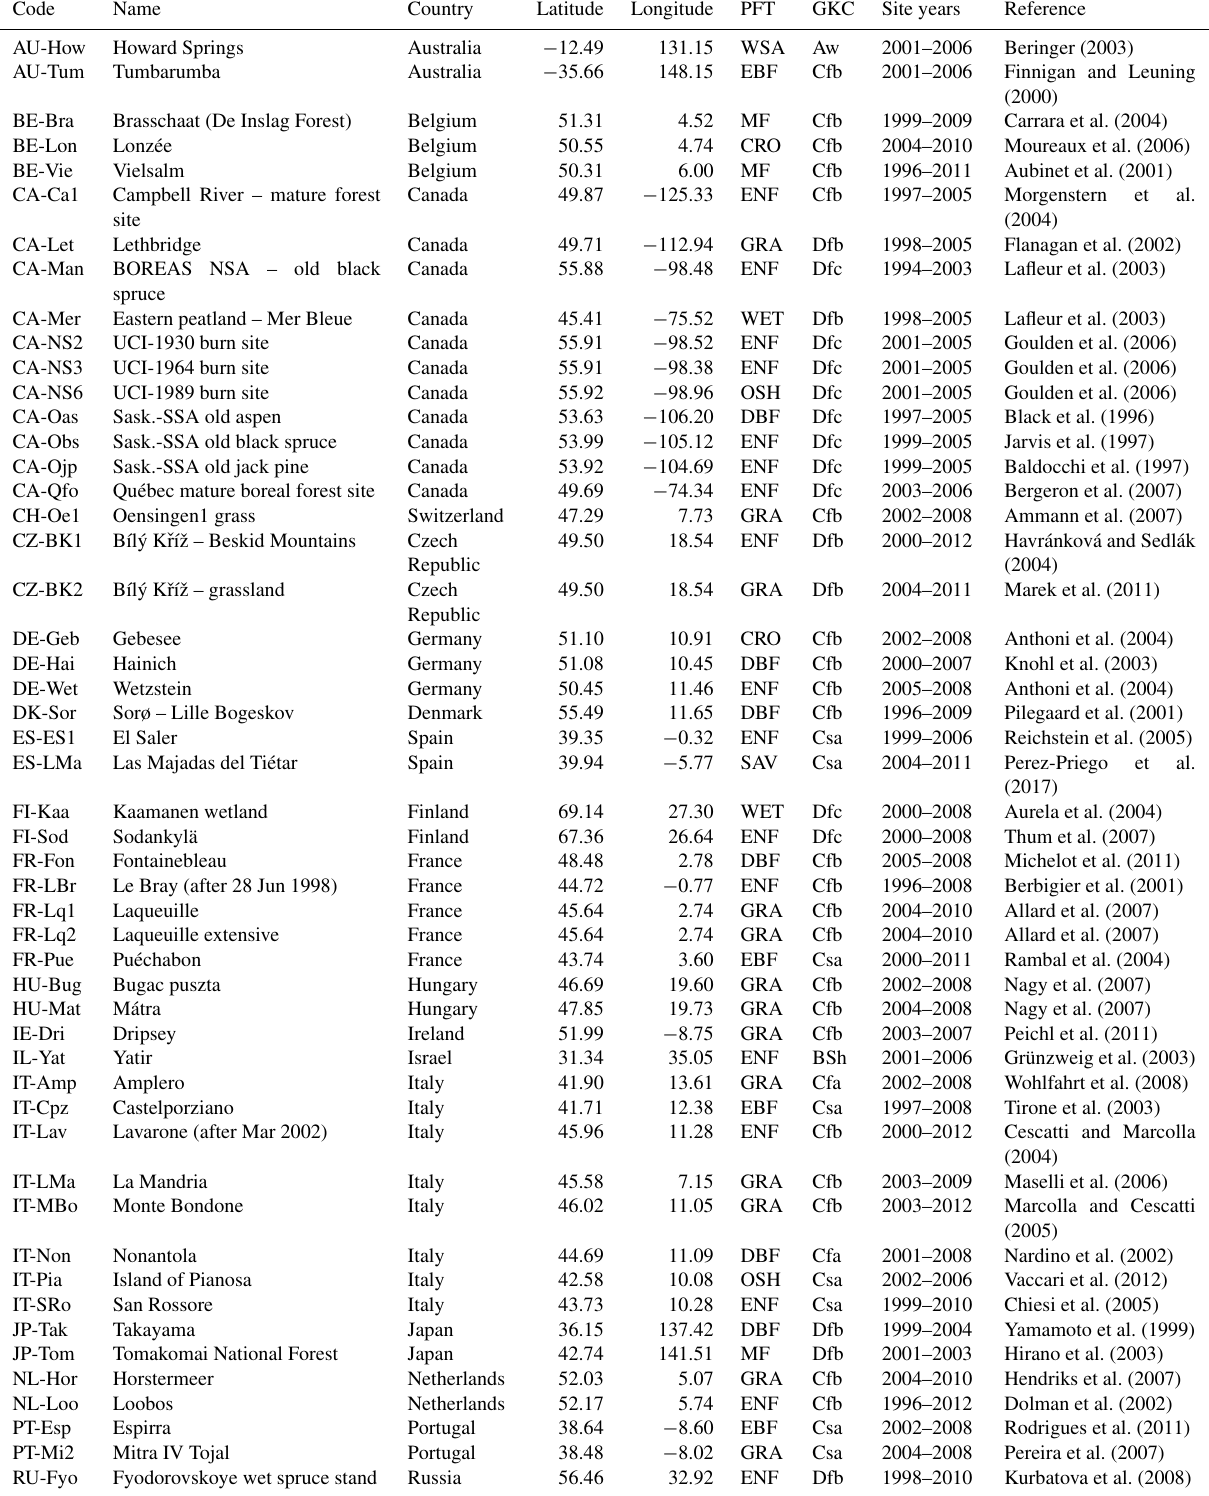
Table A3. List of FLUXNET sites used in this analysis with their code, name, country, geographical location, Geiger–Köppen climate class (GKC), plant functional type (PFT) and the measurement time periods of the data used.